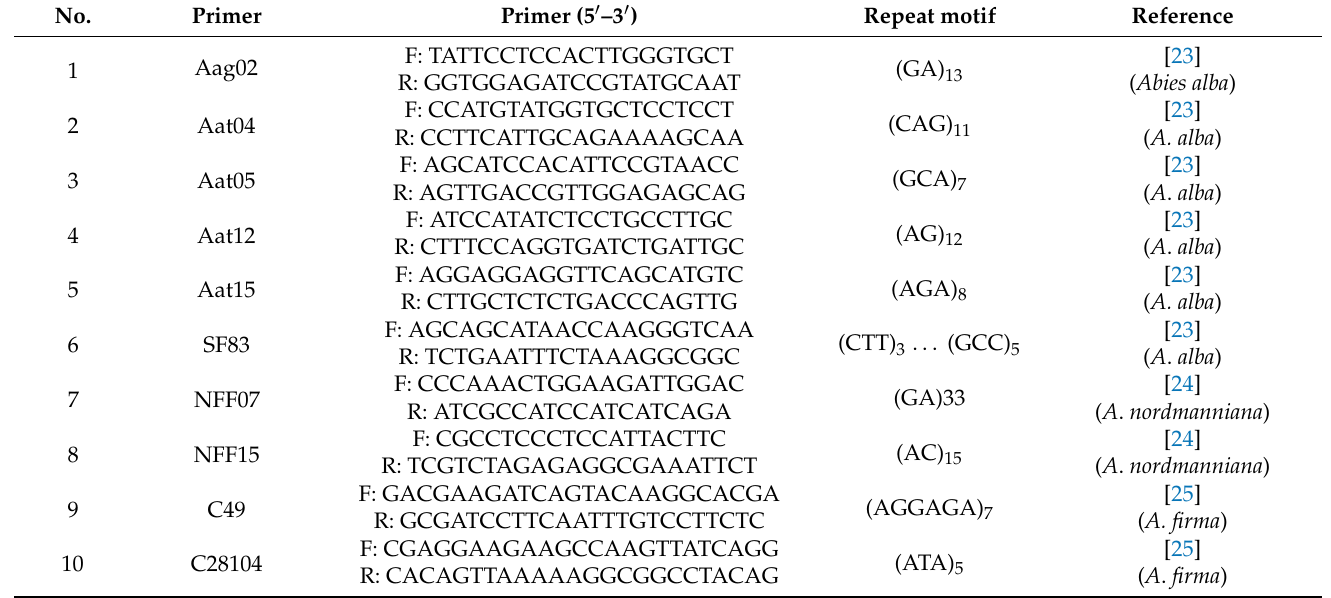
Table 2. Characteristics of microsatellite markers used in the